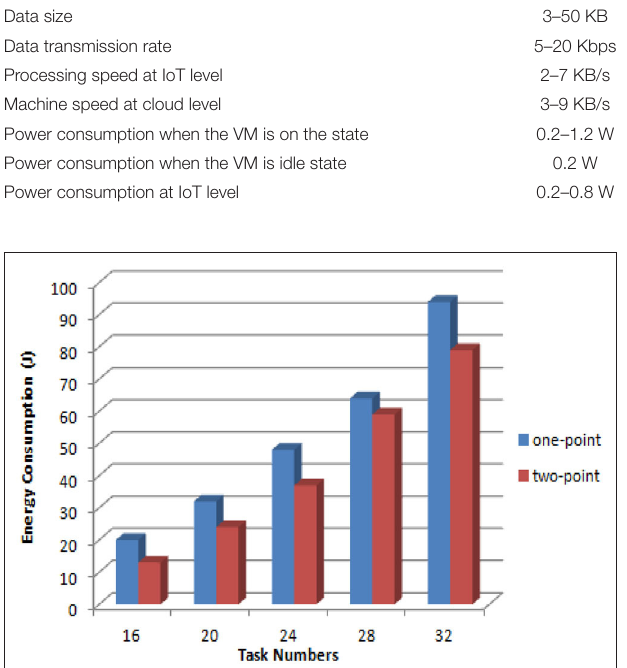
FIGURE 5 | Effect of crossover